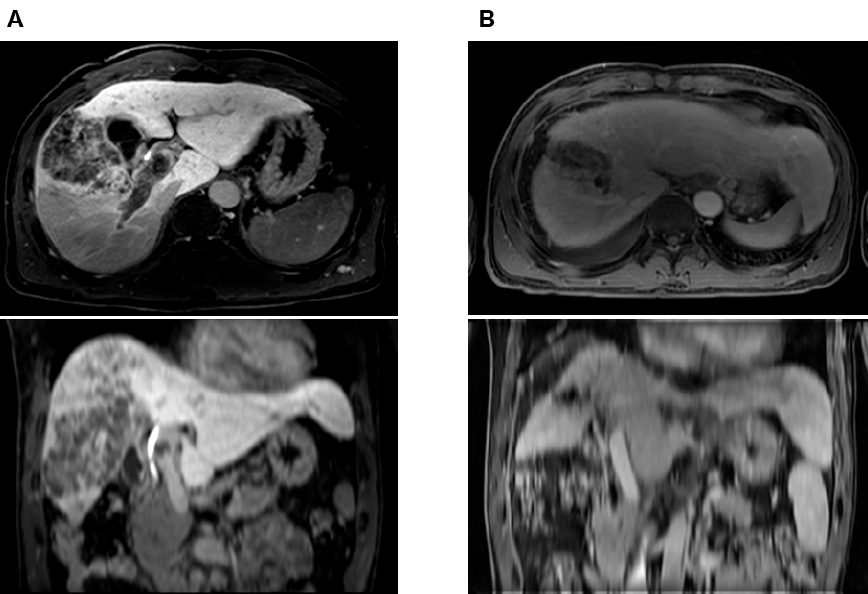
Figure 5. Case illustration of a 51-year-old male patient who received liver-directed concurrent chemoradiotherapy (LD-CCRT) followed by right lobectomy of the liver. Initial status was a 10.5 cm tumor involving both hepatic lobes associated with extensive tumor thrombosis involving right and main portal veins as well as elevated tumor markers. After LD-CCRT, significant tumor response was obtained with decreased tumor markers. Right lobectomy of liver was performed 4.5 months after the conclusion of LD-CCRT, and pathology report showed total necrotic tumor with no evidence of tumor thrombosis at portal vein. ( A ) Pretreatment axial and coronal MRI images showing locally advanced HCC with PVTT in right and main portal veins, ( B ) axial and coronal MRI images showing successful downstaging of tumor with reduced extent of PVTT 3 months after LD-CCRT. A dramatic decrease in tumor markers was also noted: alpha-fetoprotein and protein induced by vitamin K absence-II values of 63,430.93 ng/mL and 131 mAU/mL initially dropped to 4.97 ng/mL and 16 mAU/mL one month after LD-CCRT, respectively. The patient is alive without evidence of tumor recurrence at 101.5